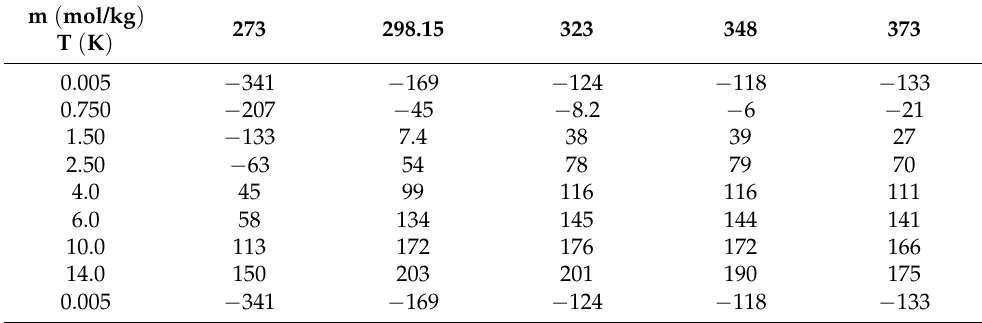
Table A26. Apparent molar heat capacities of the solution H 2 O-Ca(NO 3 ) 2 . m ( mol/kg )